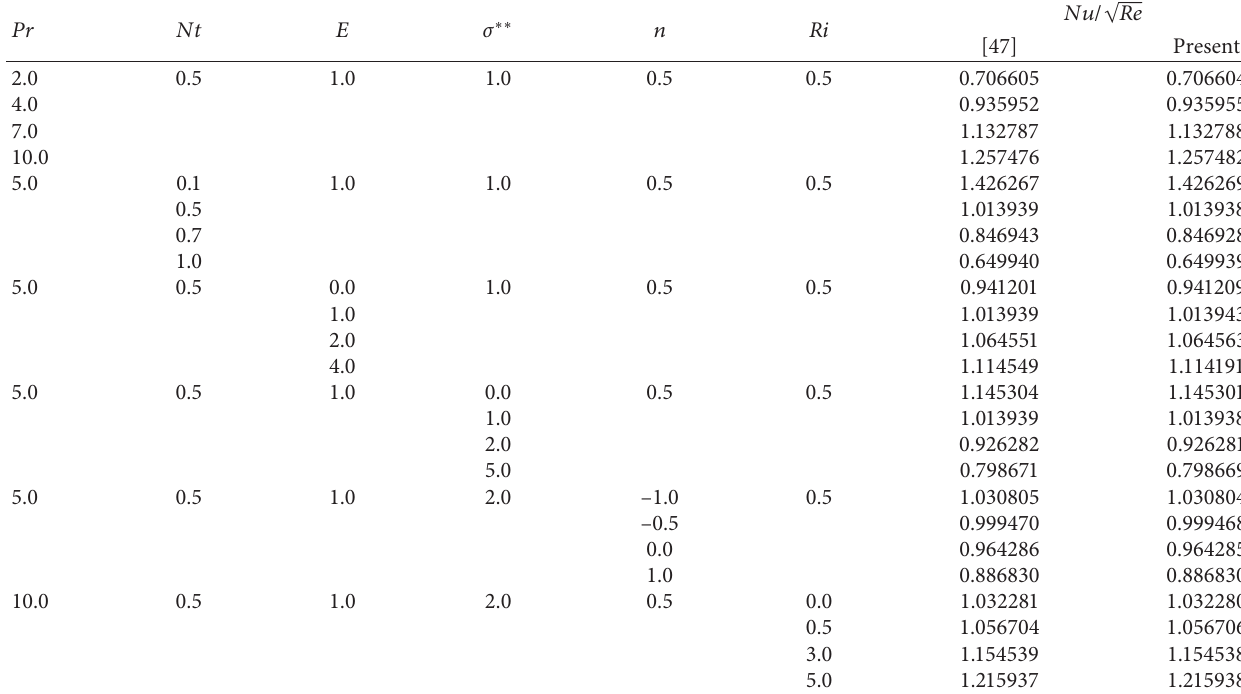
� Hg � Γ � 0, M � Nr � 0 . 5 ,Sc � 5 , and δ � 1 by Mustafa T C